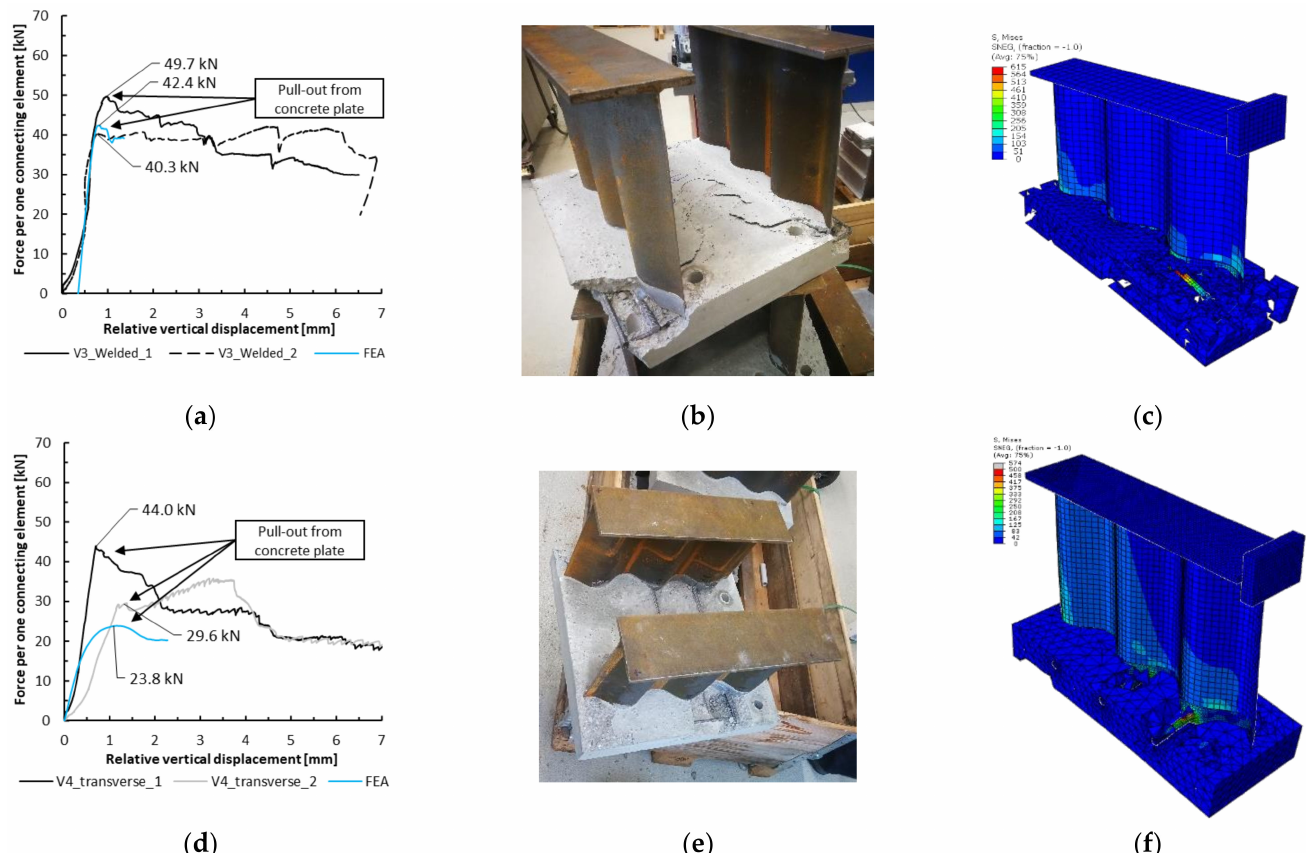
Figure 9. Test results: concrete panel and SIN beam, with fixed concrete panel ( a ) load-deformation diagram with results from laboratory tests (black and grey) and FEA-simulations (blue and purple); ( b ) specimen post failure in the laboratory test; ( c ) finite element specimen post failure, deformation superelevated two times ( d ) load-deformation diagram with results from laboratory tests (black and grey) and FEA-simulations (blue and purple); ( e ) specimen post failure in the laboratory test; ( f ) finite element specimen post failure, deformation superelevated ten